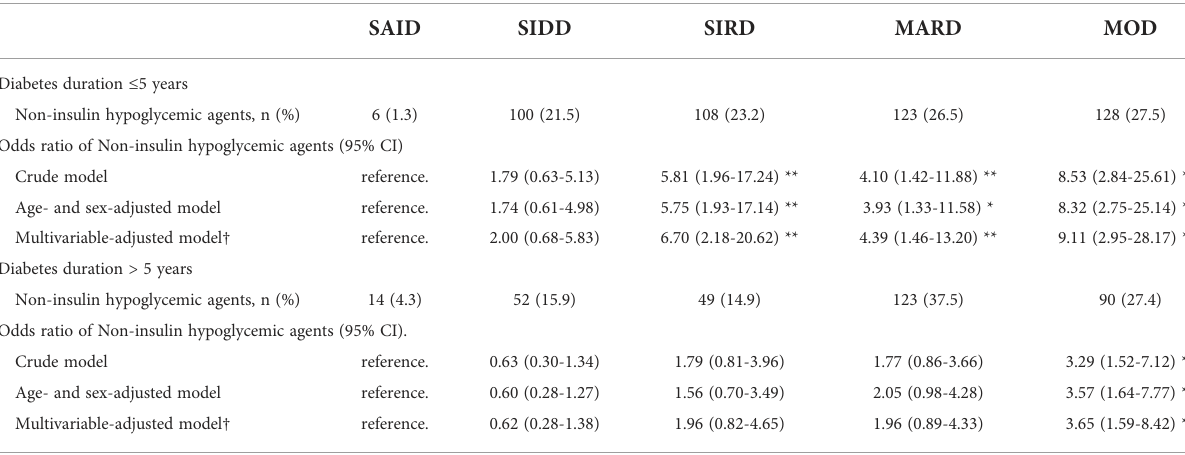
TABLE 2 Odds ratio of Non-insulin hypoglycemic agents (vs diet only or insulin) for each diabetes subgroup. Diabetes subgroup SAID